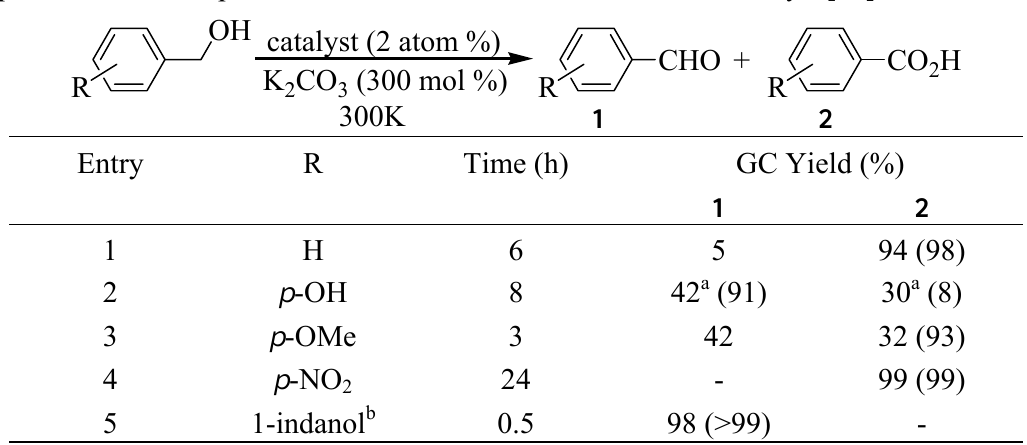
O :PVP/Au . Values 3 4